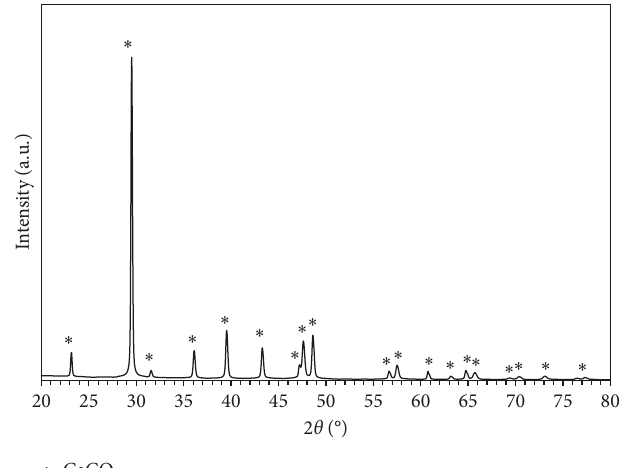
Figure 1: XRD pattern of as-received duck eggshell powder used in this work.